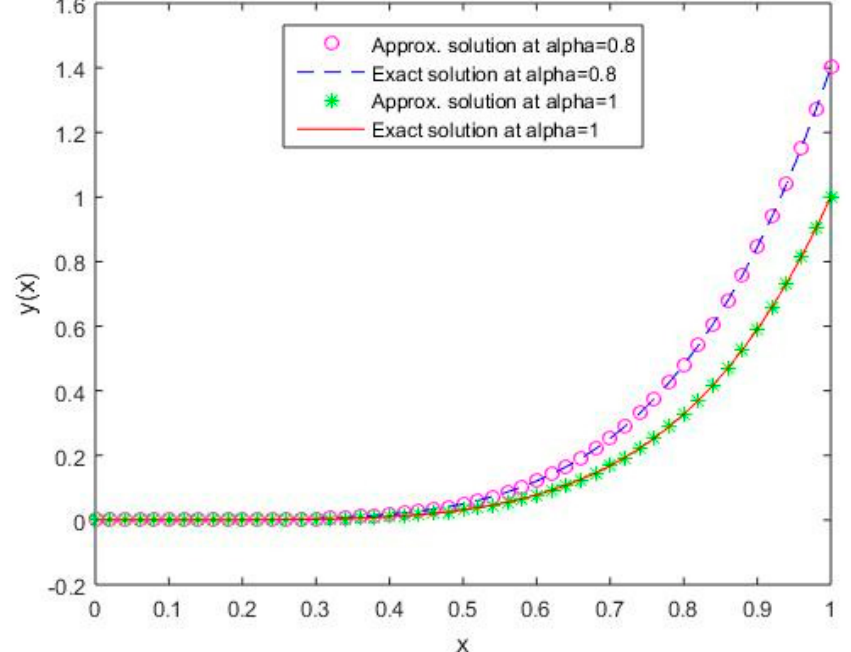
Figure 1. Comparison of exact and numerical solutions using S1 for 𝛼 = 0.8 and 𝛼 = 1 , Example 1.